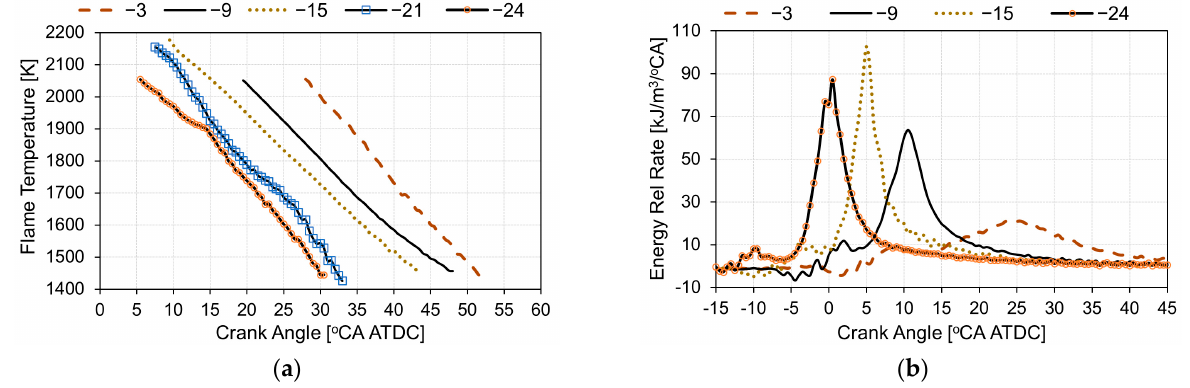
Figure 8. Flame temperature ( a ) and energy release rate ( b ) during an SOI sweep at 59% EGR and 8 mg/cycle fuelling quantity. Legend entries are SOI in °CA ATDC.